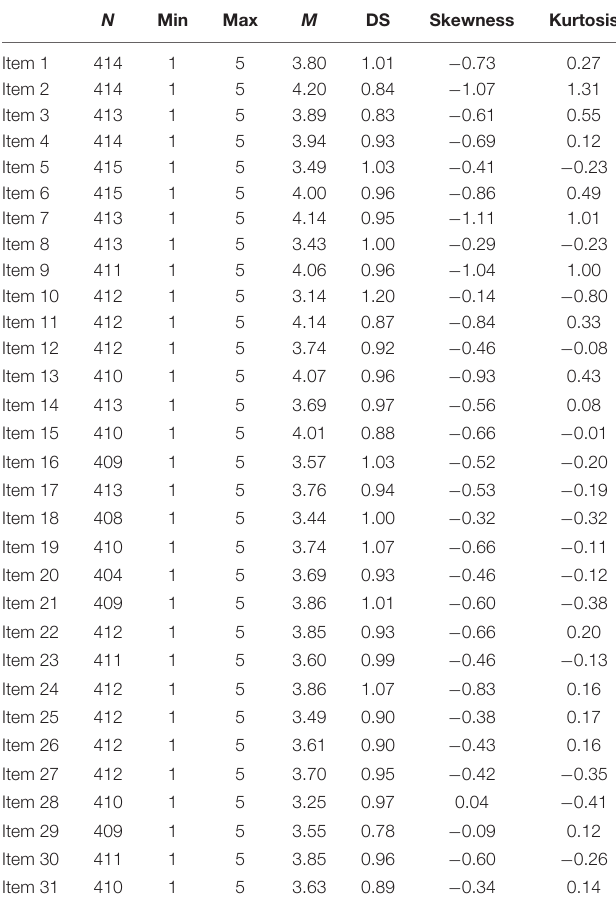
TABLE 1 | Descriptive statistics of the 31 items of the SRL-SRS for Sport